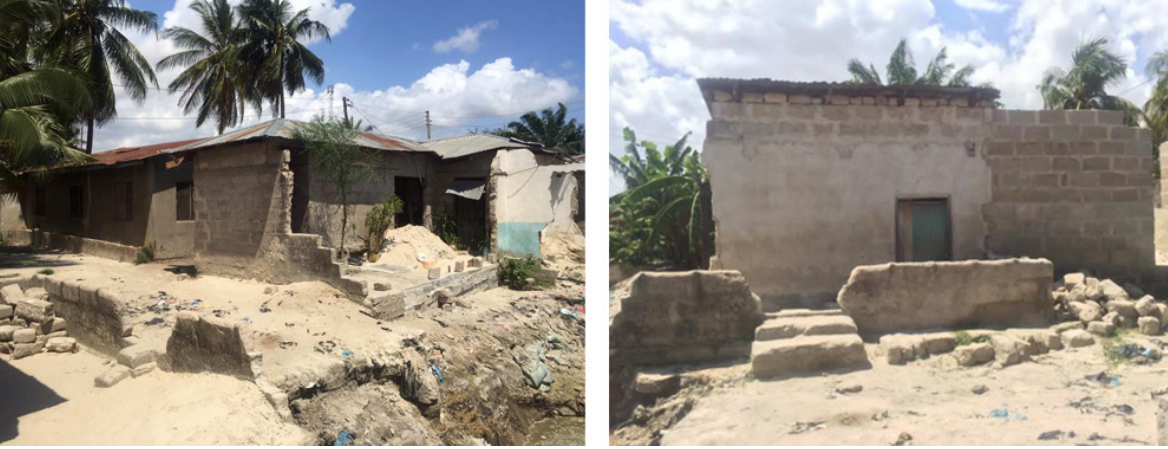
Figure 10. Damaged Swahili houses in Tandale by Ng’ombe River. Source: Courtesy of Beatrice Mahagama and Leticia George.